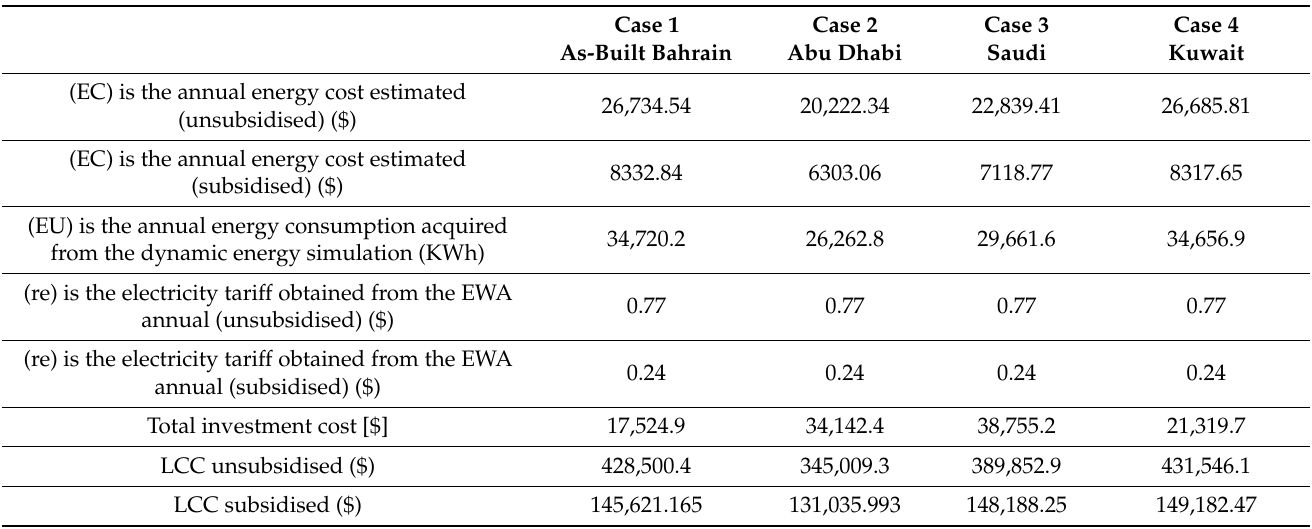
Table 9. Lifecycle cost for the examined design scenarios including subsidised and unsubsidised energy